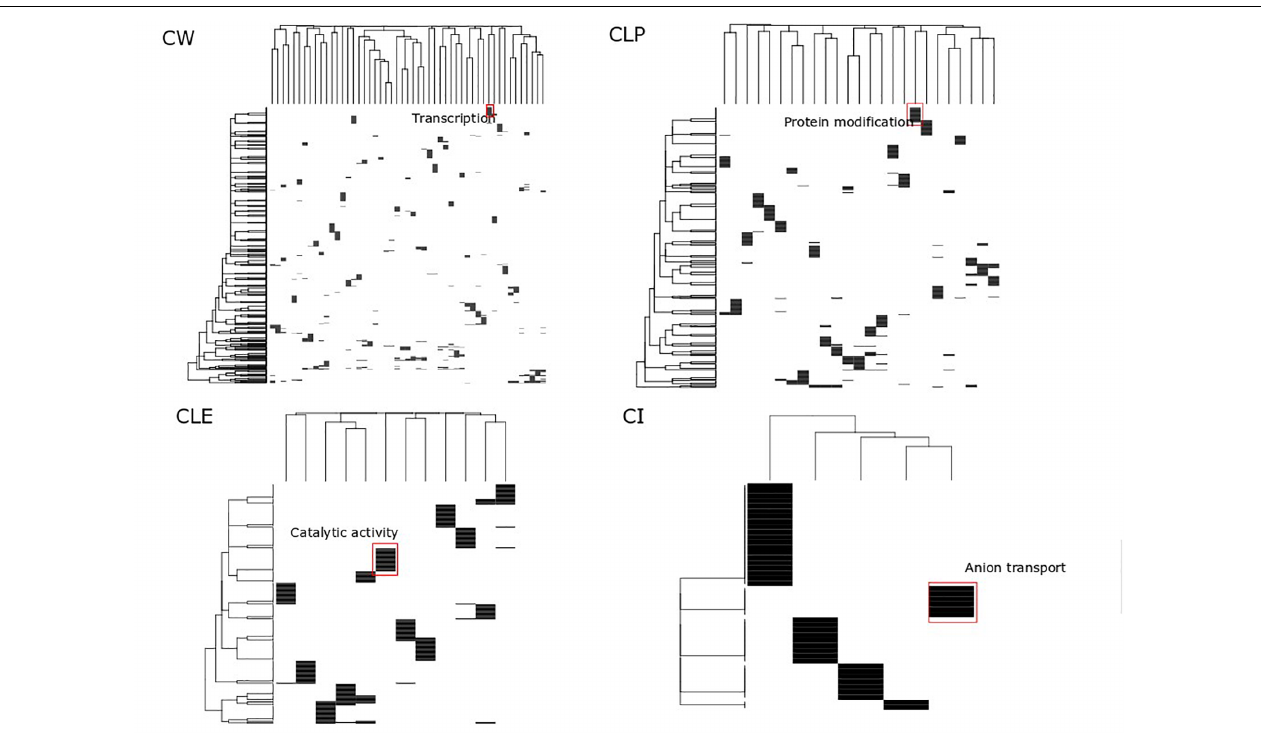
FIGURE 4 | Functional analysis of big size clusters. This heatmap displays the top 20 significant associations between clusters and biological processes across four clusters detection algorithms. Color denotes enrichment of a given cluster with a biological process, hypergeometric log p -value after Benjamin–Hochberg adjustment. Cluster height reflects the number of interrelated processes associated with the given cluster. Cluster weight reflects clusters that shared this significant function. For major cluster based on each cluster detection algorithm, key biological themes are